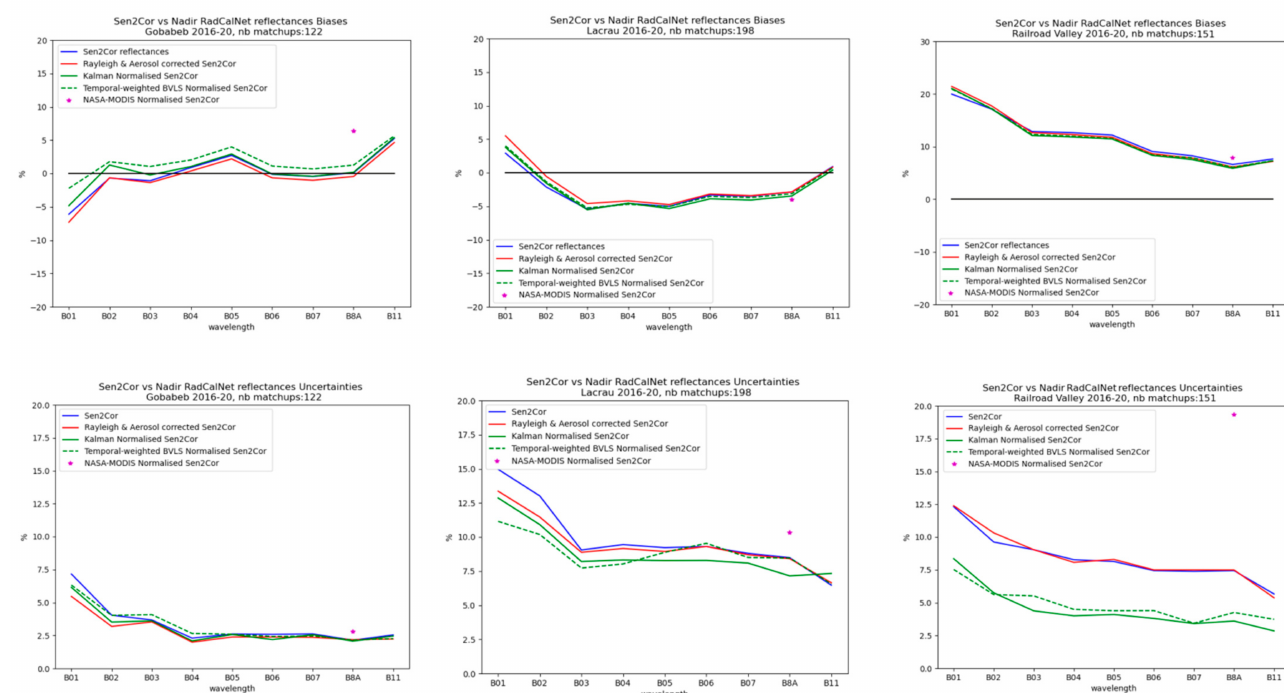
Figure 3. Statistical assessment of normalized Sen2Cor reflectances vs. in-situ data using the Roujean Kernels. Top, accuracy (biases) and bottom, uncertainties. The red stars correspond to the normalization results obtained using directly the MODIS band 2 BRDF MCD43A1 (500 m resolution) parameters and the related Ross-Li kernels.